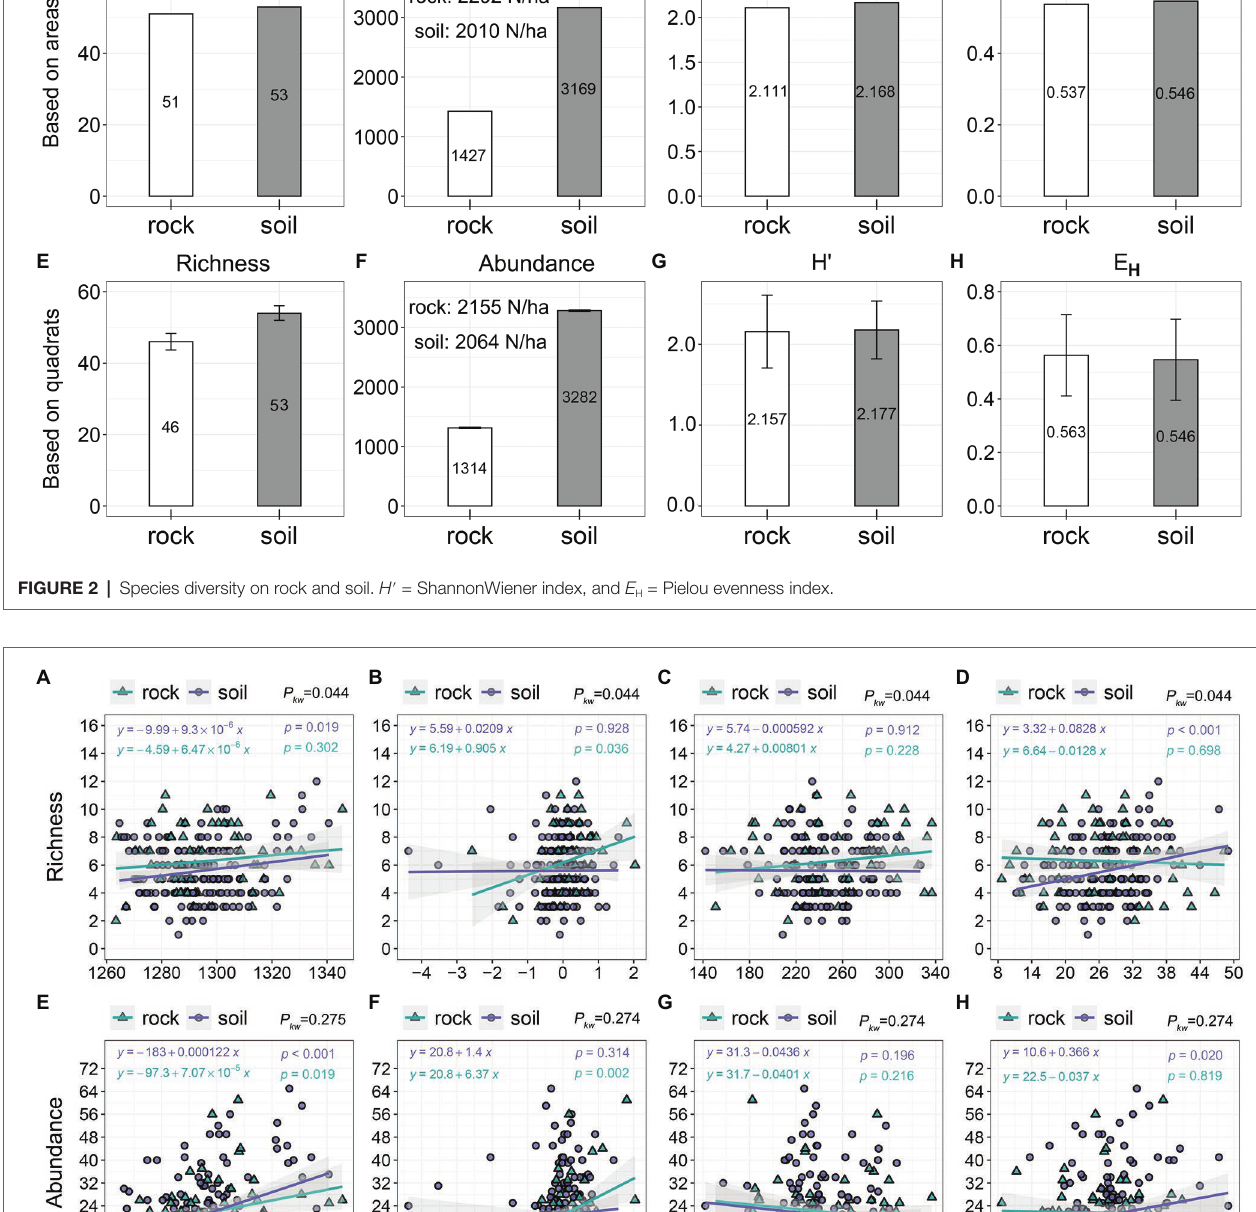
whereas elevation and convexity were positively correlated with the abundance of trees ( Figure 8B ). Slope was positively correlated with the richness and negatively correlated with the